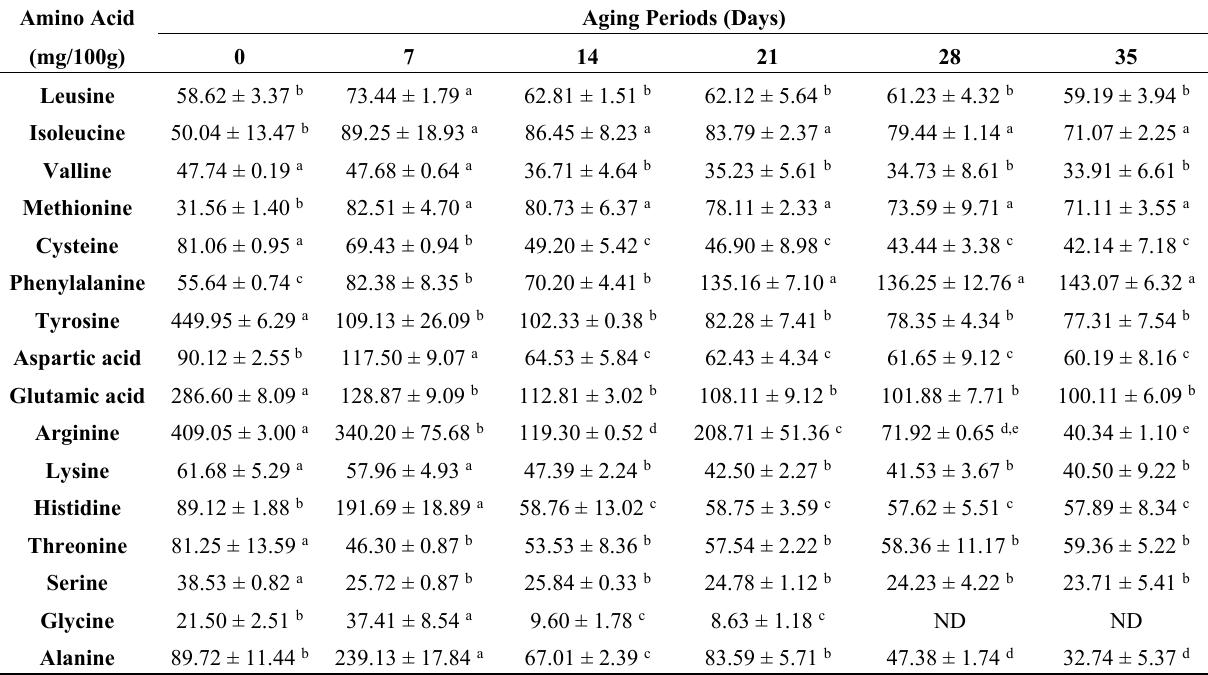
Table 2. Amino acid contents of black garlic during the aging period. Aging Periods